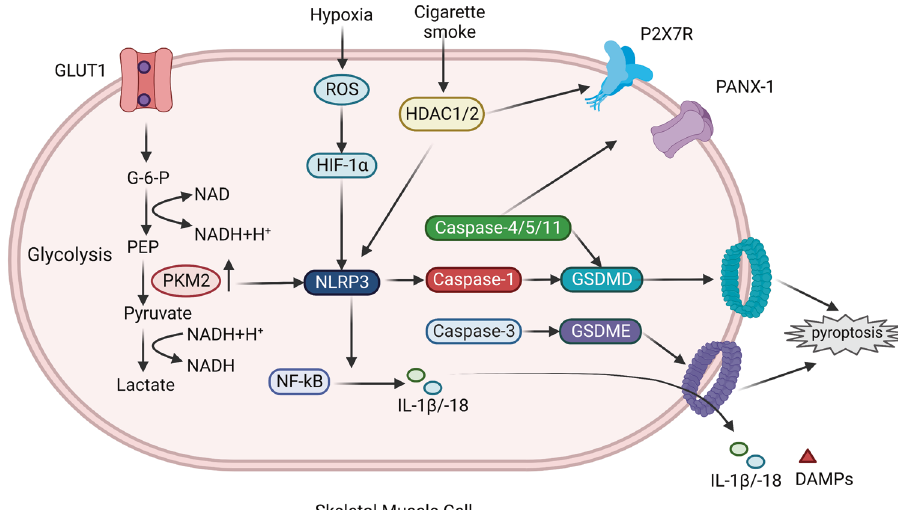
Fig. 5 Pyroptosis in Muscle Disorders. Pyroptosis and abnormal function of skeletal muscle cells mediate a series of muscle diseases. The pathogenesis of IIM is associated with glycolysis, and increased PKM2 activity promotes NLRP3 activation. ROS generation induced by hypoxia activates NLRP3 through HIF-1 α , and cigarette smoke stimulation enhances HDAC1/2 activity, which is involved in NLRP3, P2X7R and Panx-1 activation. The pyroptosis pathway mediated by caspase-3 and GSDME also leads to membrane pore formation. These pathways interact